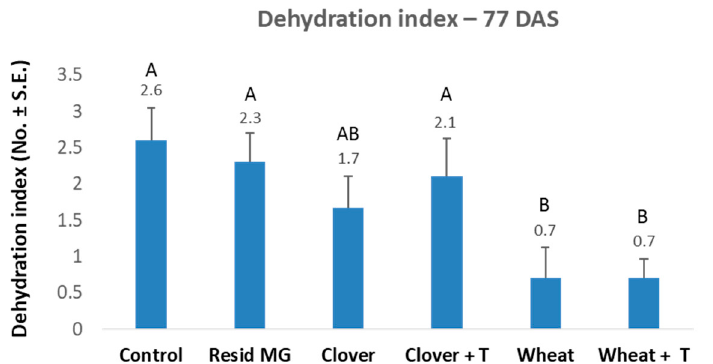
Figure 3. The 2019 soil microbiome integrity experiment–dehydration assessment at the experiment’s end (77 DAS). The experiment is described in Figure 1. The controls included the same prior crop soil but with tillage (+T) or soil that had not been cropped before the maize growth (control). Additionally, similar control with commercial Resid MG product (Arbuscular mycorrhizal, Glomus iranicum var. tenuihypharum ) was tested. Wilt assessment was based on four categories related to the whole plant: healthy (1), minor symptoms (2), dehydrated (3), and dead (4). Vertical upper bars represent the standard error of the mean of 10 replications. Statistically significant (one-way ANOVA, p < 0.05) differences between treatments at the same measures are indicated by different letters (A–B). Table 3. The 2019 soil microbiome integrity experiment—growth parameters at 77 DAS 1 .